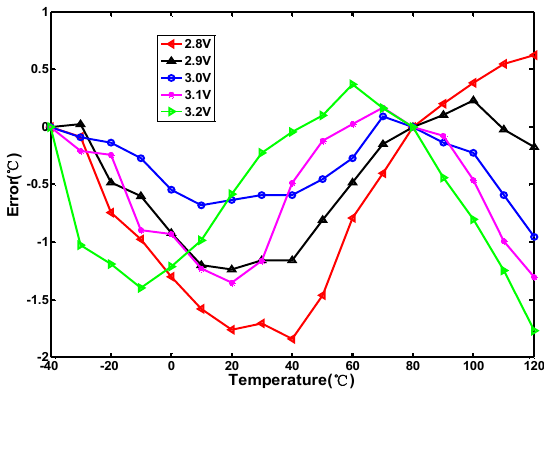
Figure 13. Measurement errors in the range of − 40–120 ° C for supply voltage